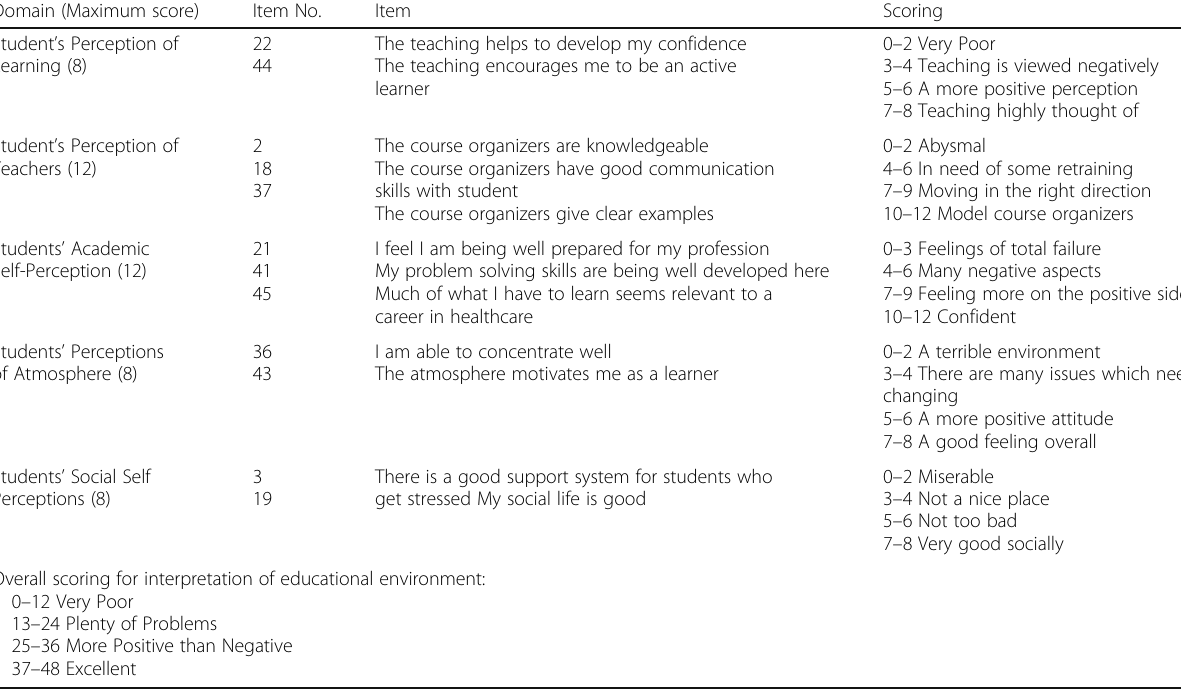
Table 3 Items selected to form DREEM-12 and the applicable scoring system Domain (Maximum score) Item No.